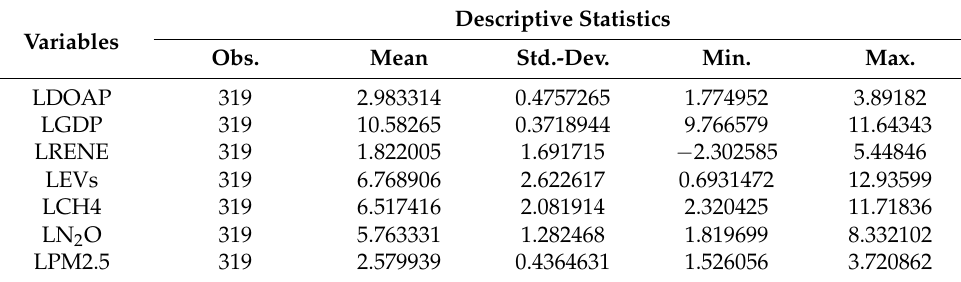
Table 3. Descriptive statistics of variables.